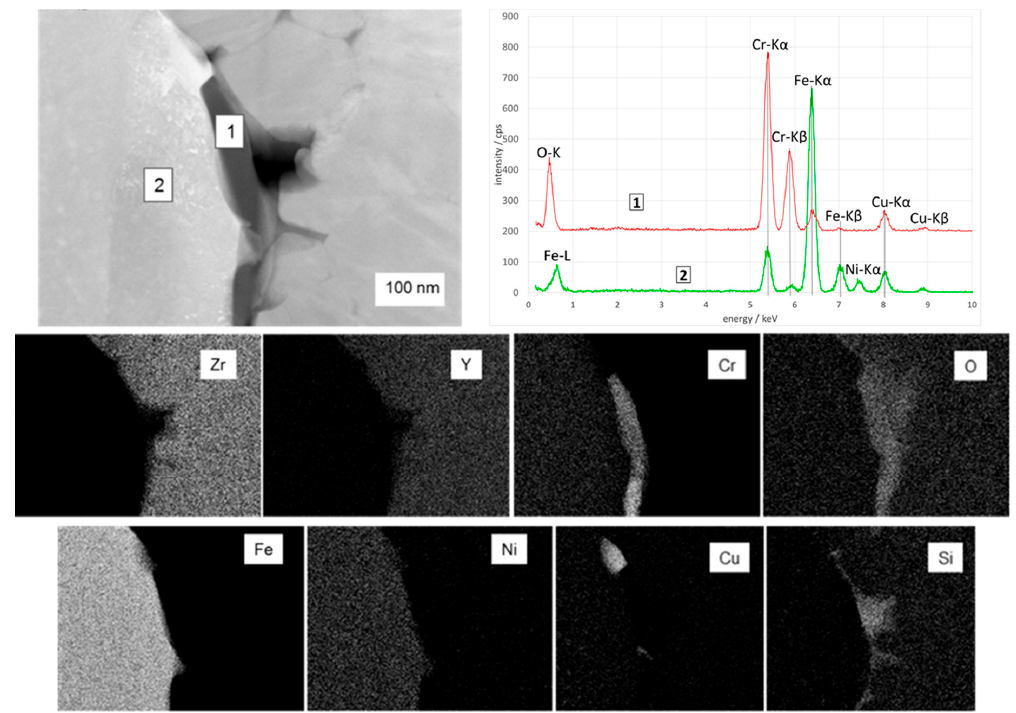
Figure 5. TEM image with EDX mappings of the 17-4PH/YSZ interface phase.